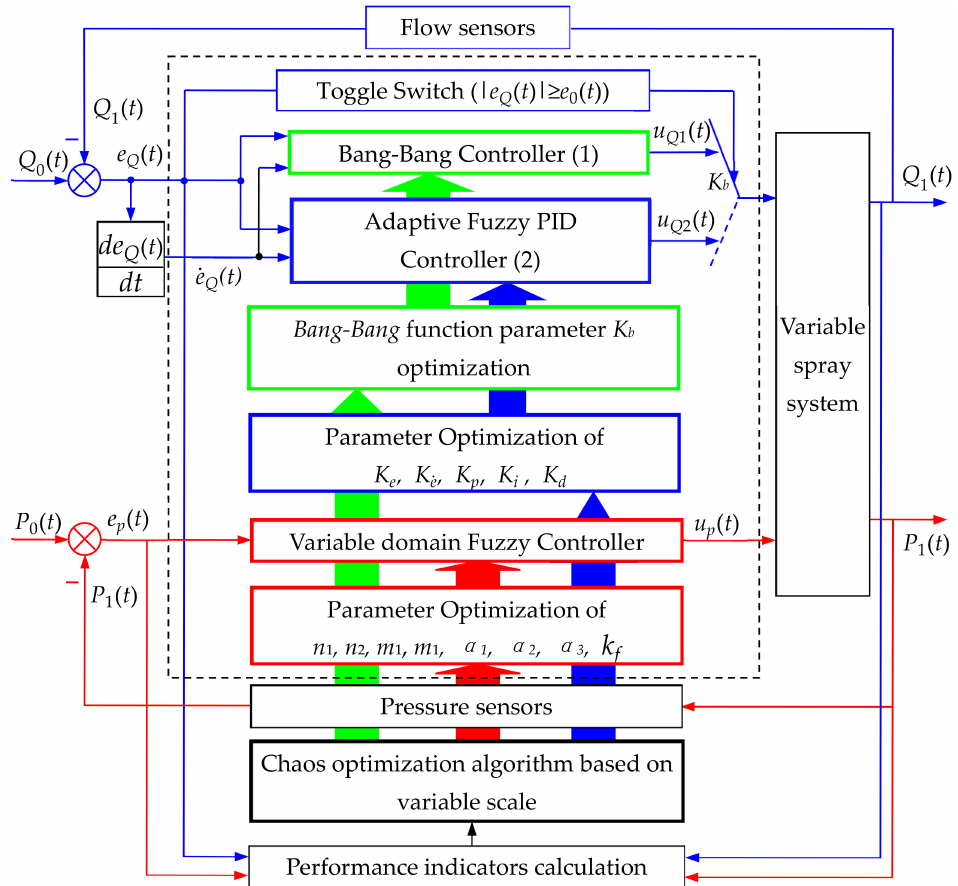
Figure 5. Parameter optimization structure of controller (1), controller (2) and controller (3). Note: K b is the critical value of u Q 1 ( t ) q switched to u Q 2 ( t ) . K e is the quantization factor of e Q ( t ) and K .